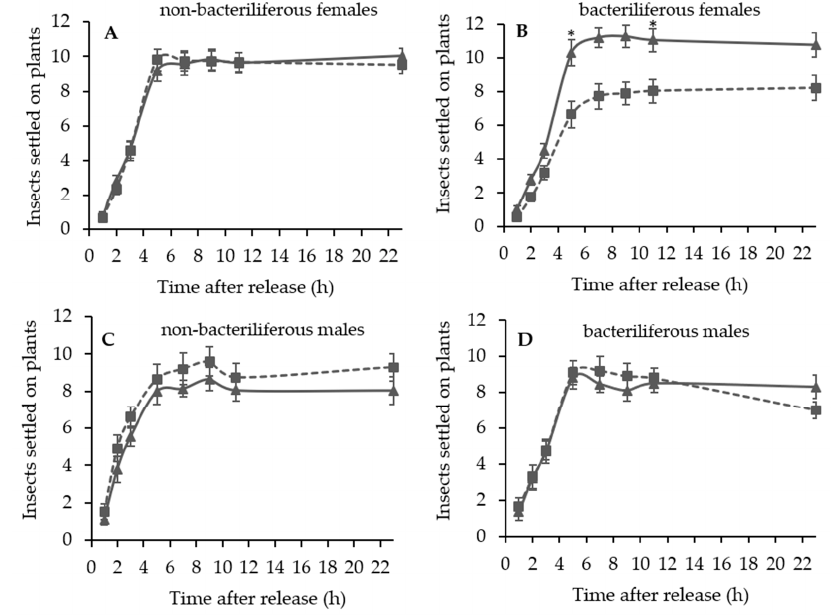
Figure 1. Average number ( ± SEM) of Dalbulus maidis adults on leaves of healthy “mock-inoculated” (solid line) vs. maize bushy stunt phytoplasma (MBSP)-infected asymptomatic (dotted line) maize plants, at successive time periods after insect release in the choice arena. ( A ) Non-bacteriliferous females; ( B ) Bacteriliferous females; ( C ) Non-bacteriliferous males; ( D ) Bacteriliferous males. Means at 5 and 11 h after release were compared by t -test and the asterisk (*) represents statistical difference ( p < 0.05).